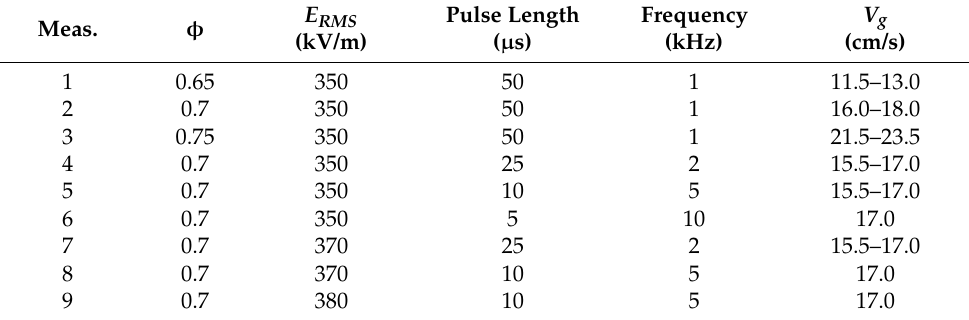
Table 2. Experimental conditions investigated in the current study. The equivalence ratio was varied in measurement 1–3, the pulse duration and repetition frequency of the microwave pulses were varied in measurements 4–6, and, in measurement 7–9, the electric field strength was increased compared to the other measurements.